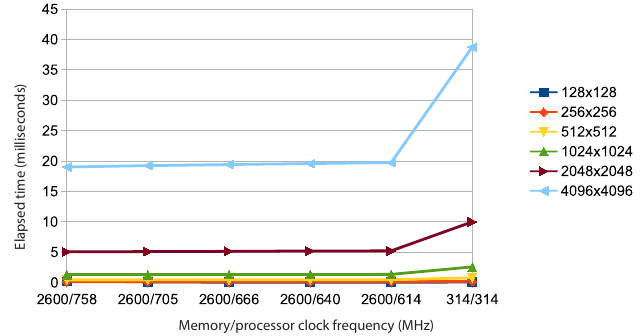
Figure 20. Update task elapsed time.